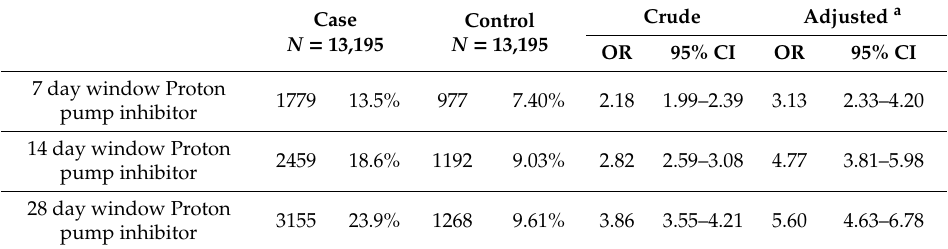
Table 2. Hepatic encephalopathy risk associated with current proton pump inhibitor use.